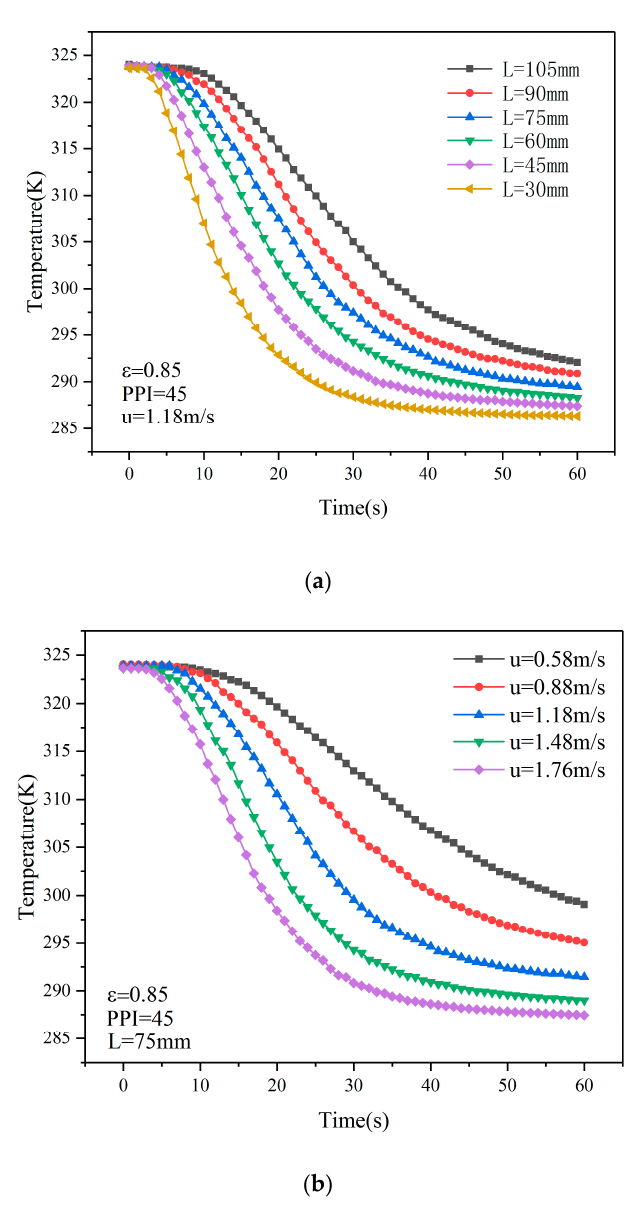
Figure 2. Curve of outlet temperature change with time in foams: ( a ) Different thickness, ( b ) different Curve of outlet temperature change with time in foams: ( a ) Di ff erent thickness, velocity. ( b ) di ff erent